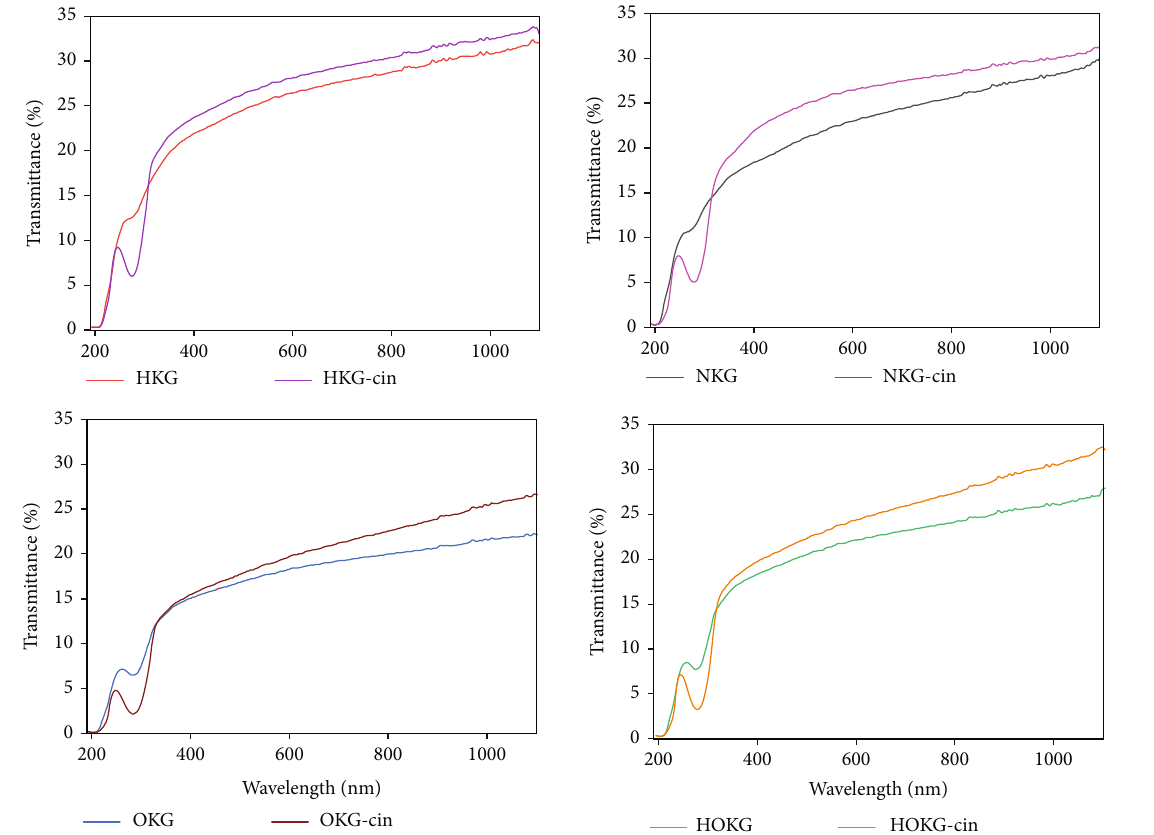
Figure 7: UV-vis spectra of starch-KG fi lms with and without 5%